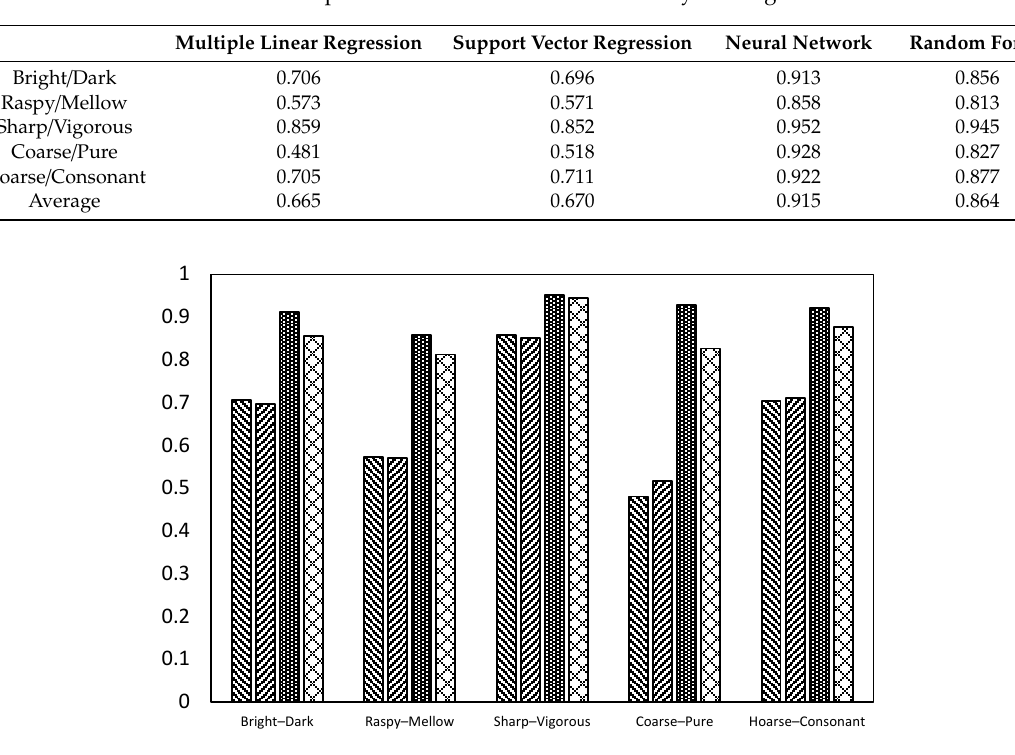
Table 7. A comparison of the accuracies achieved by four algorithms.